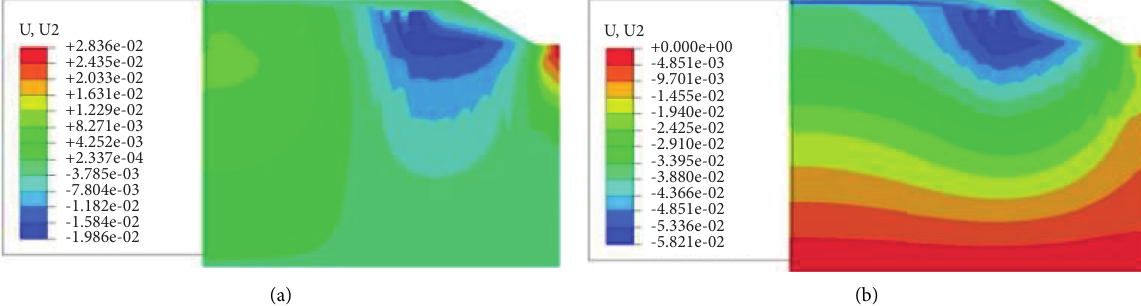
Figure 3: Settlement cloud diagram of the widened subgrade for a pile spacing under the existing road slope equal to 300% of the pile diameter. (a) Settlement cloud diagram of subgrade completion. (b) Settlement cloud diagram 15 years after subgrade construction.